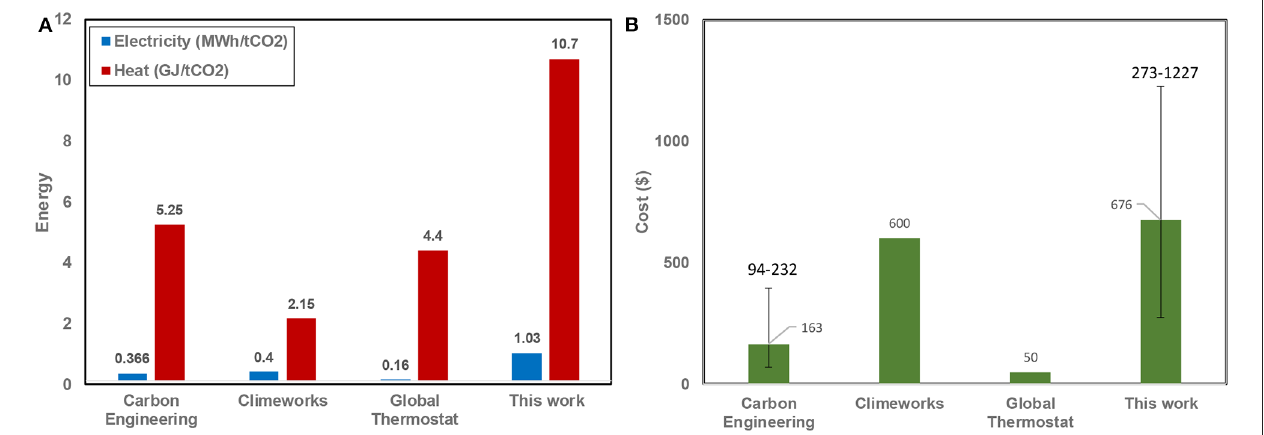
FIGURE 10 | (A) Energy consumption and (B) total cost reported in different studies for direct air capture processes. Note that $50/tCO 2 reported by Global Thermostat was the cost that they anticipated to achieve. No information whether they have achieved this. Also, this work and Carbon Engineering’s study reported a range for the cost of the process, based on various economic